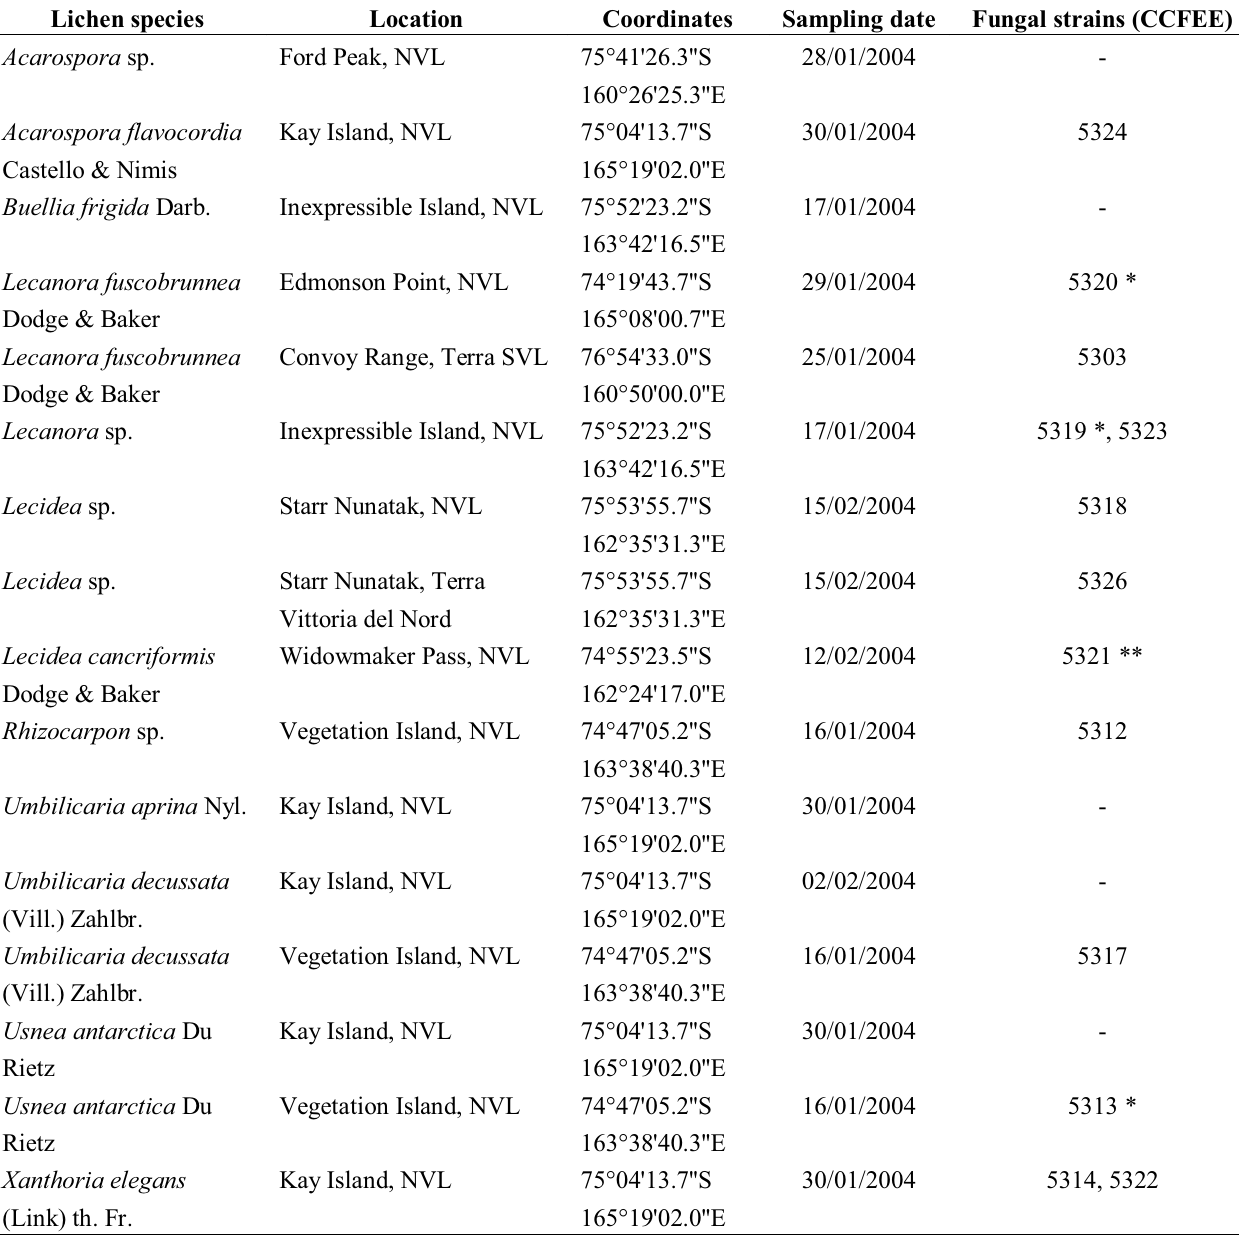
Table 1. Lichen species analyzed collection data and fungal strains isolated. Lichen